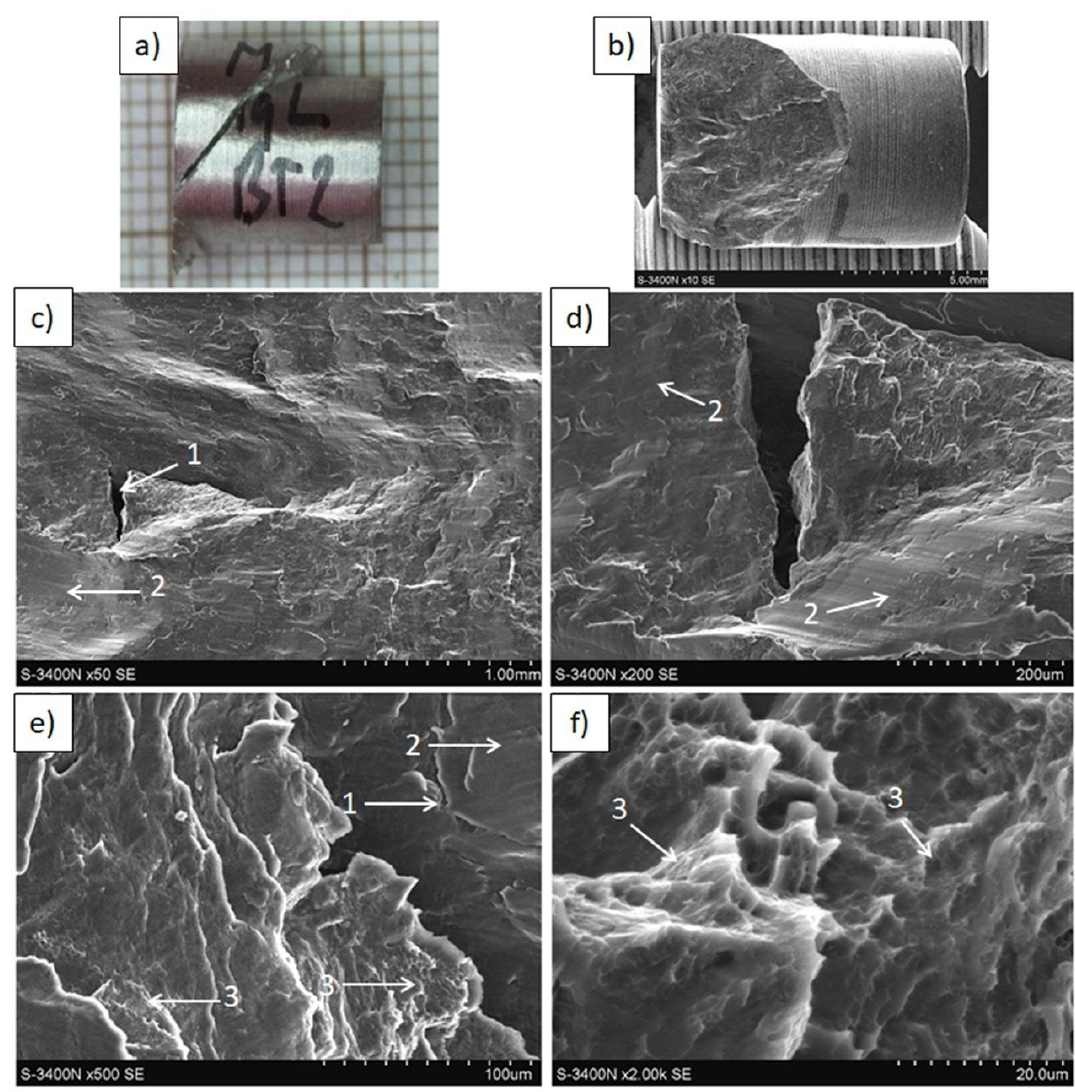
Figure 16. Decohesion effects in Mg(C) rod after compressive strength test. View of sample ( a , b ) fracture of quasi-brittle type with approx. 45° angle. SEM micrographs of fracture surface: ( c – f ) cracks (1), smooth areas of cleavage metal fracture (2), plastic deformed metal dimples (3).